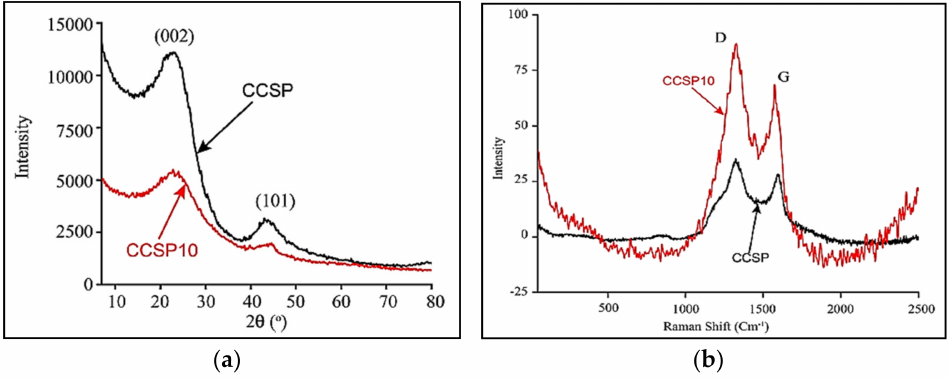
Figure 10. ( a ) XRD of CCSP and CCSP10 and ( b ) Raman spectrometry of CCSP and CCSP10 [72].